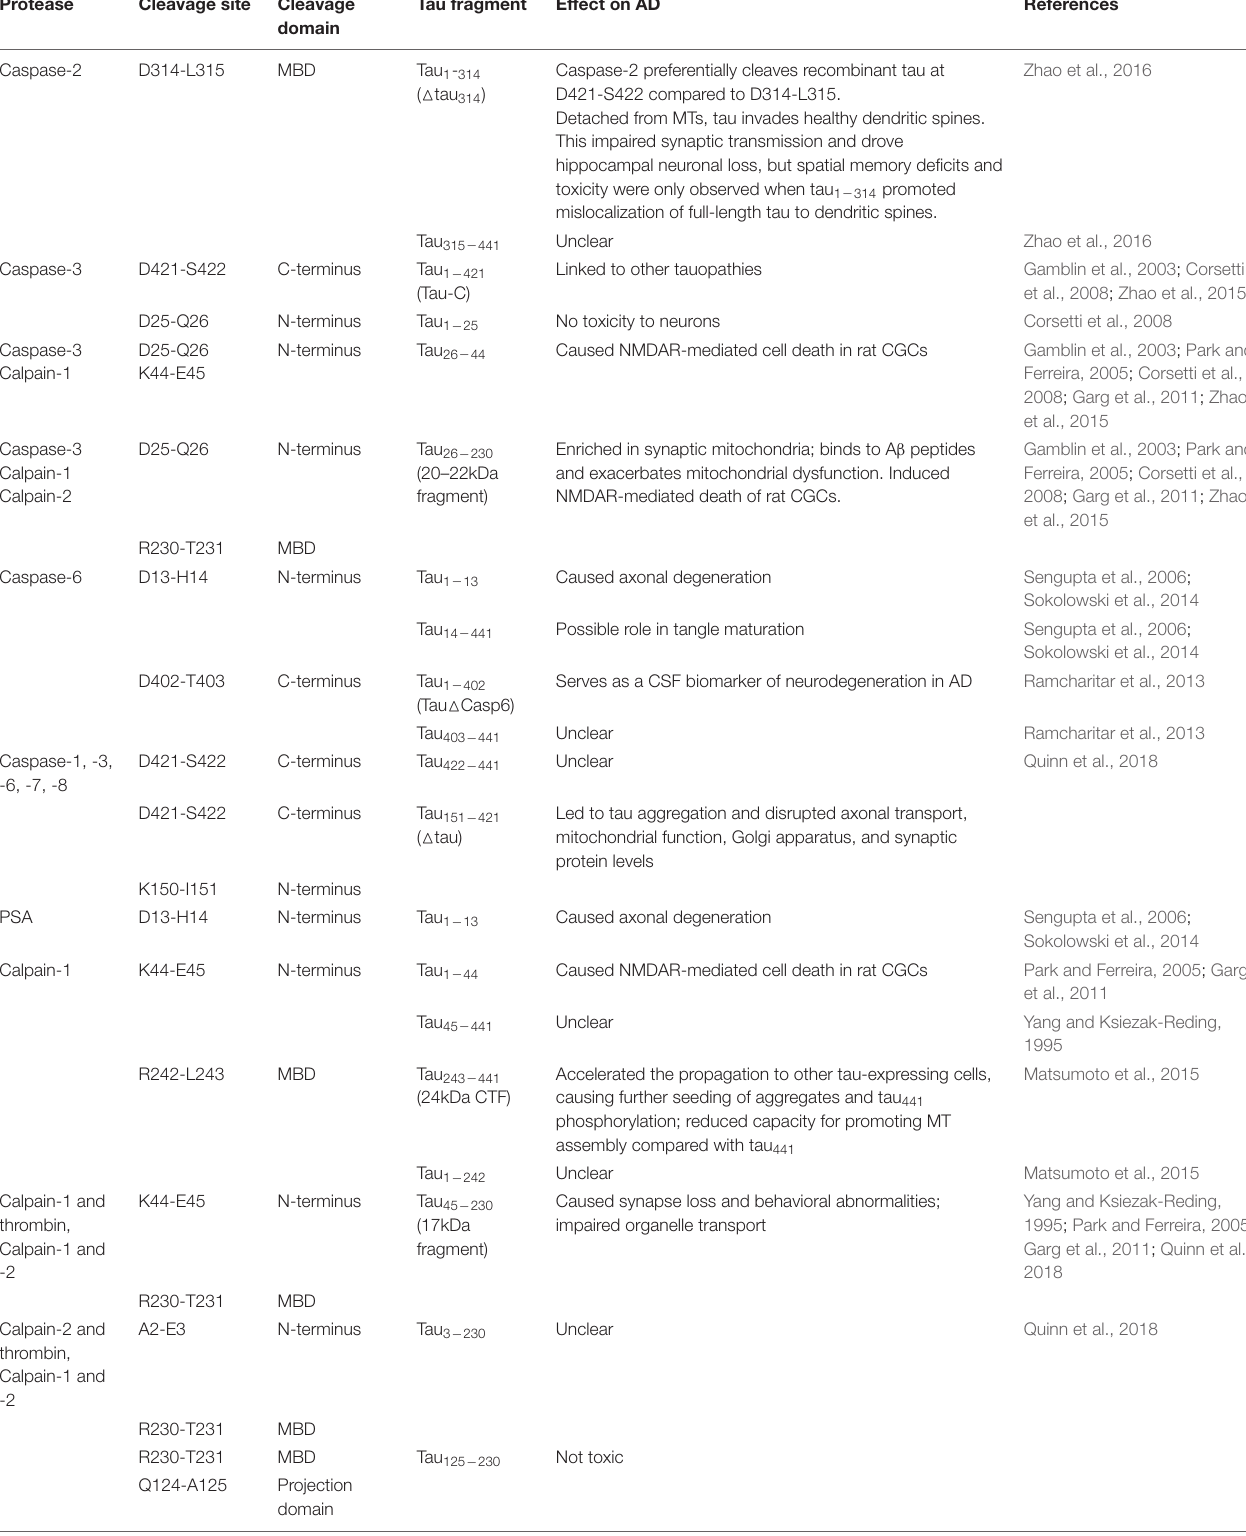
TABLE 1 | Tau protein cleavage at different sites by known